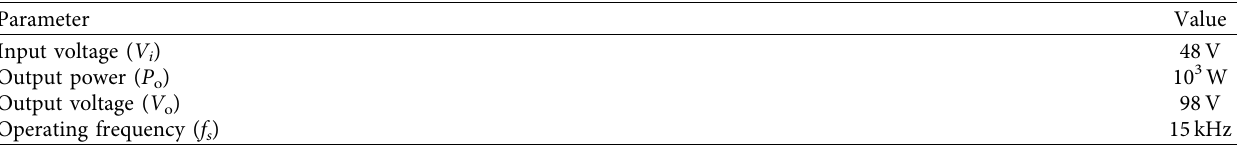
Figure 11: Switching signal of VSI during regenerative braking. Table 2: Design parameters.